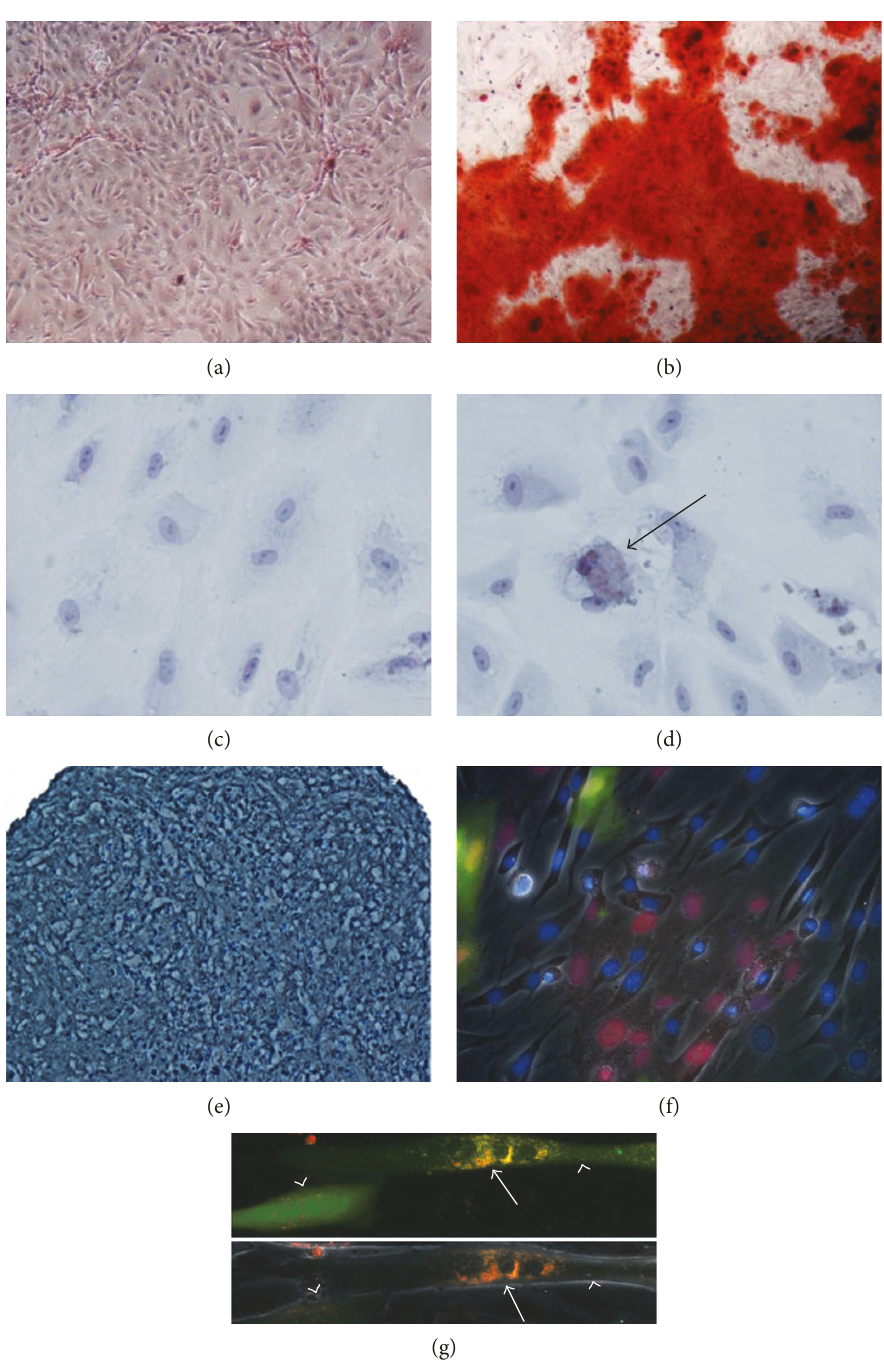
Figure 4: Multiple-di ff erentiation potentials of hAFMSCs in vitro. Osteogenic di ff erentiation of hAFMSC induction for 5 days, stained with Alizarin red: (a) noninduced control hAFMSCs and (b) induced hAFMSCs cultured in osteogenic medium containing BMP4. Adipogenesis of hAFMSCs after induction: (c) noninduced control hAFMSCs and (d) induced hAFMSCs within adipogenic medium for 5 days, as shown by positive Oil red O (arrows ’ cells). (e) Chondrogenic di ff erentiation of hAFMSCs within chondrogenesis medium with Toluidine blue staining in vitro. Using a coculture system, the same number of both myoblasts (arrows, C2C12-prelabeled red dye-bits) and hAFMSCs (arrowheads, pre-GFP-labeled, green) were 1:1 mixed (f), per placing on to one dish. The fused multinucleated myotubes could be detected at 4 days after coculturing, in which some of the myotubes were positive for both red dye and green-GFP together (g). Results suggested that the myogenic di ff erentiation potential via the myotube-fusion occurred between myoblasts and